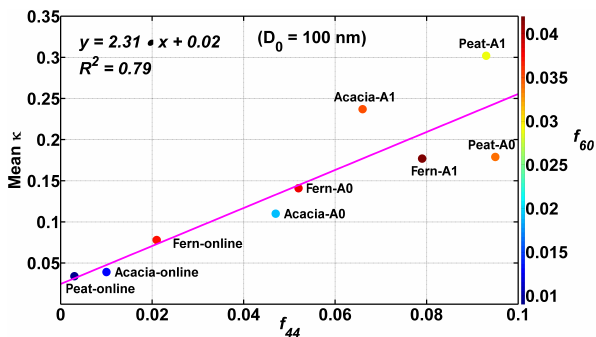
Figure 8. Correlation of κ and f 44 . The magenta line shows the result of fitting by the least-squares